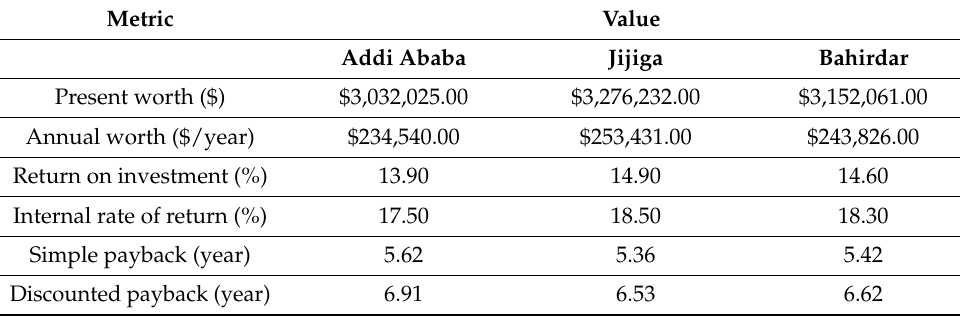
Table 5. Comparison of first rank of feasible system with base case (DG).